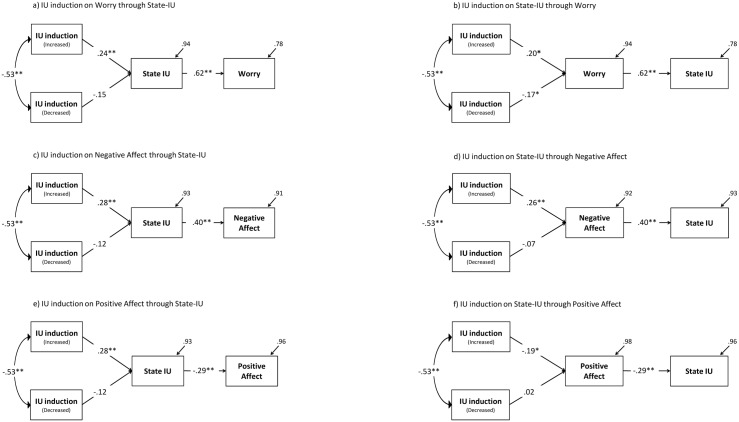
Mediation analysis.